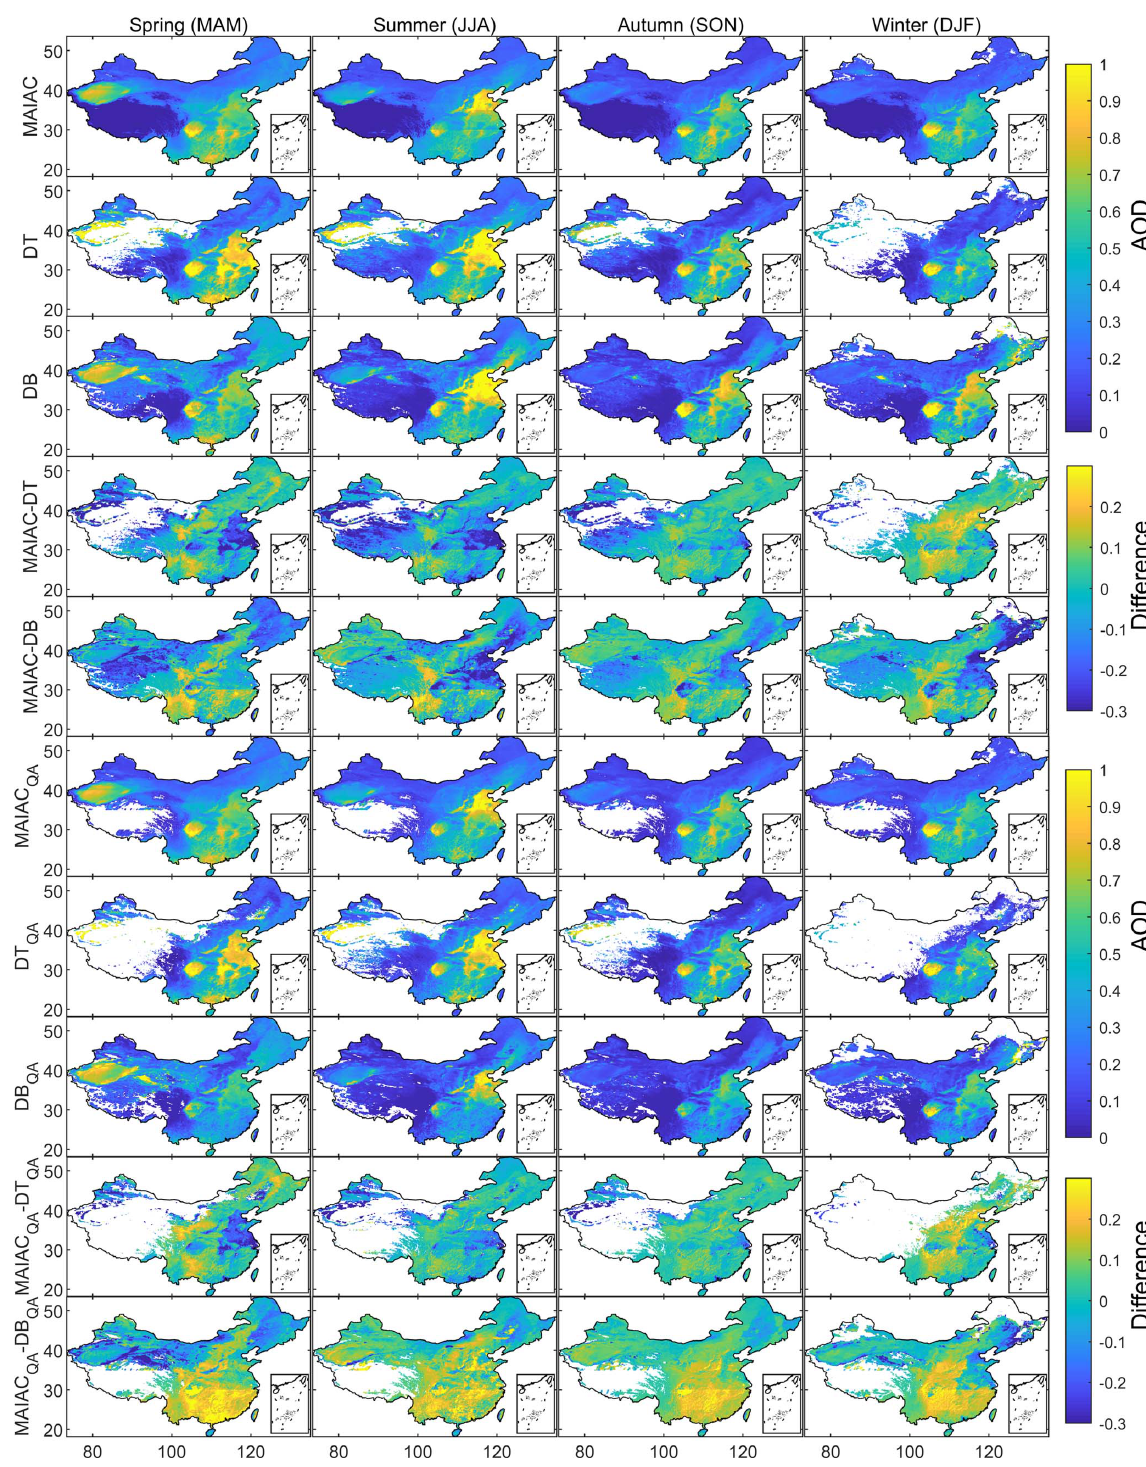
Figure 14. Seasonal averaged AOD distributions for MAIAC, DT, and DB and their differences before and after the QA filter from 2000 to 2017. The subscript QA denotes the corresponding results after the QA